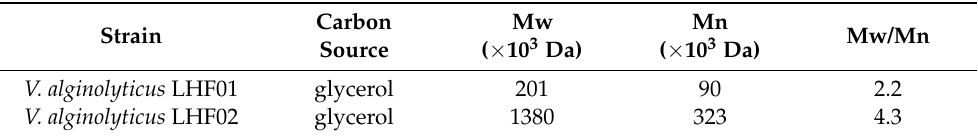
Table 2. Molecular weight of PHB produced by V. alginolyticus LHF01 and LHF02. Strain